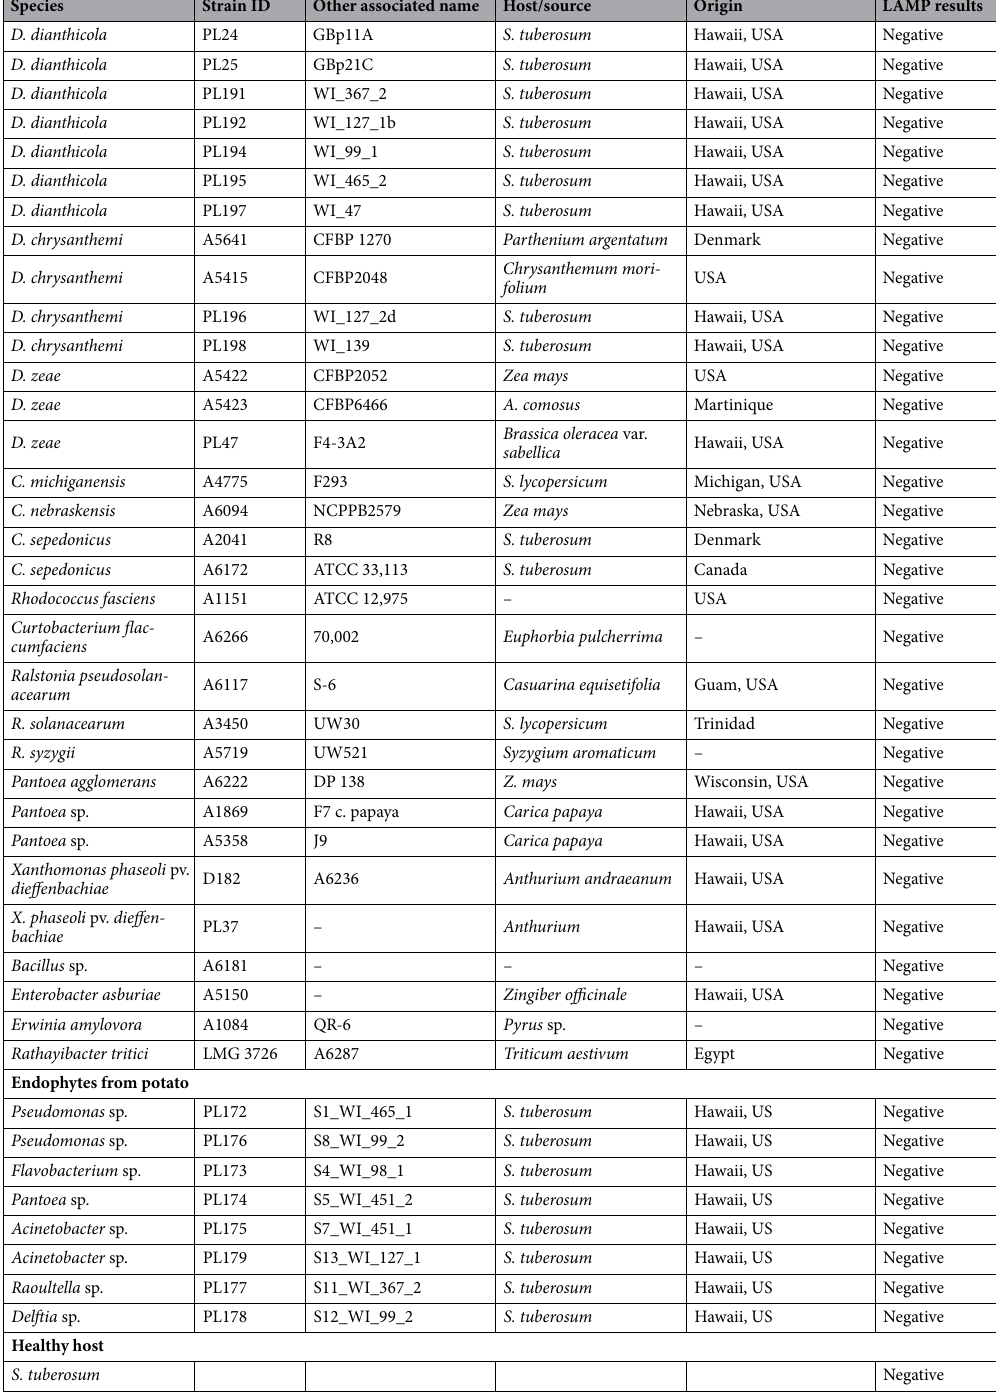
Table 3. Bacterial strains and healthy plant host samples used in the exclusivity panel for validation of loop-mediated isothermal amplification assay developed for specific and rapid detection of Pectobacterium parmentieri . Negative (−) sign indicates data not